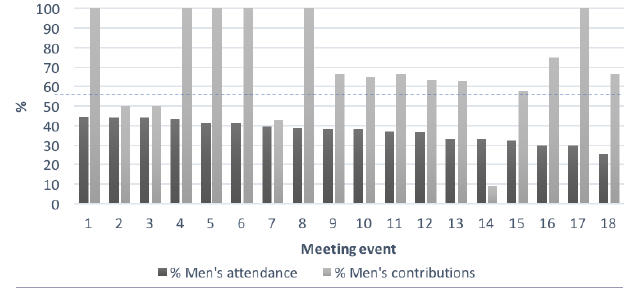
Fig. 4 . Men’s attendance and contribution to